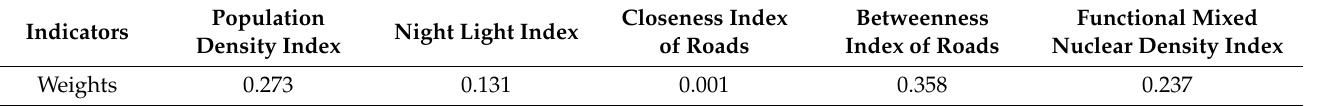
Figure 11. Functional mixed nuclear density index. Table 5. Weights of the five categories of risk